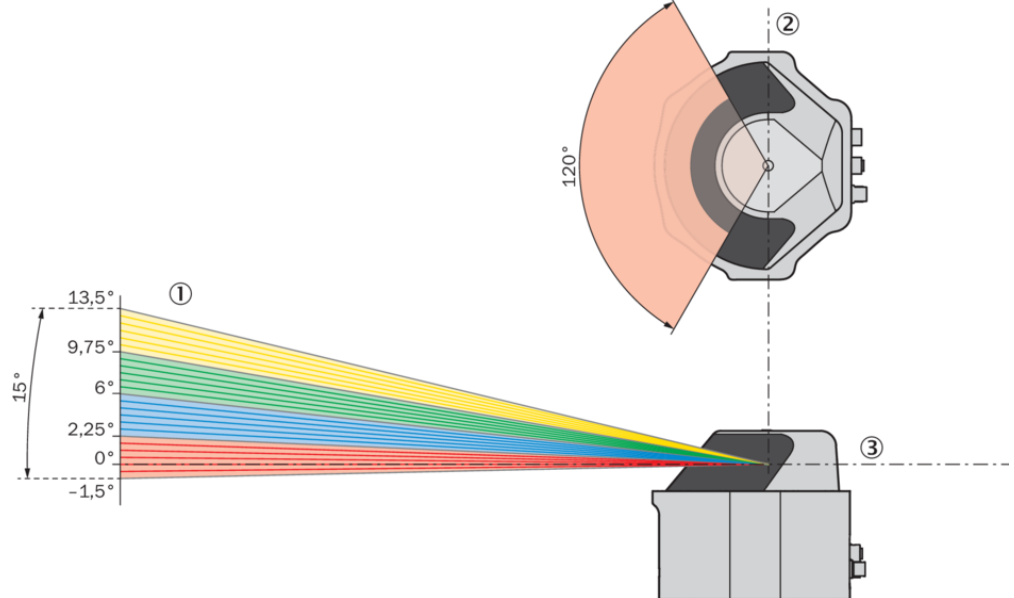
Figure 14. MRS 6000 range of scanning. Source: